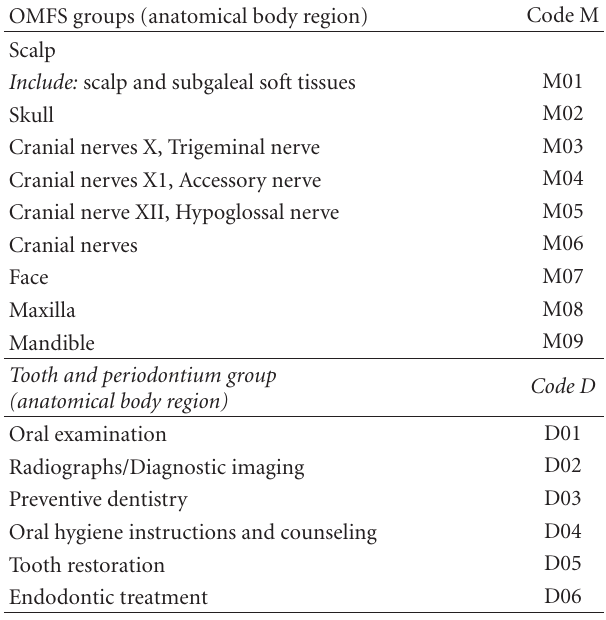
Table 1: Examples of both groups (M and D), split into procedure clusters using the anatomy group by body region.